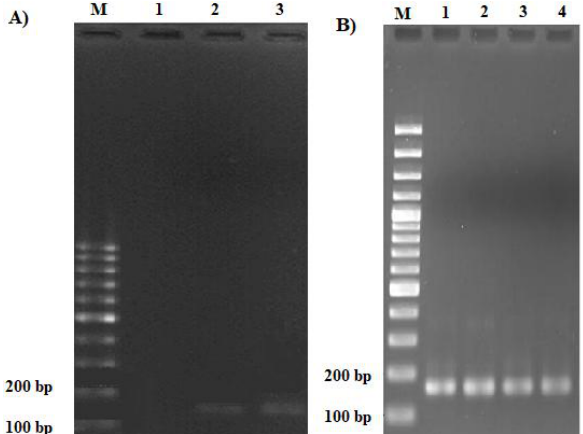
Fig. 2. The pattern of cDNA fragments amplified by the β-actin gene primer (B) and NFAT5 (A); A) NFAT5 gene expression in PBMCs (175 bp). Lane M: 100 bp size ladder (Fermentas, Germany), Lane 1: negative control, Lanes 2 and 3: NFAT-5 expression of the subject group in PBMCs (175 bp); B) β-actin gene Expression in PBMCs (161 bp). Lane M: 100 bp size ladder (Fermentas, Germany), Lanes 1- 4: β-actin gene expression in PBMCs of both subject groups (161 bp).